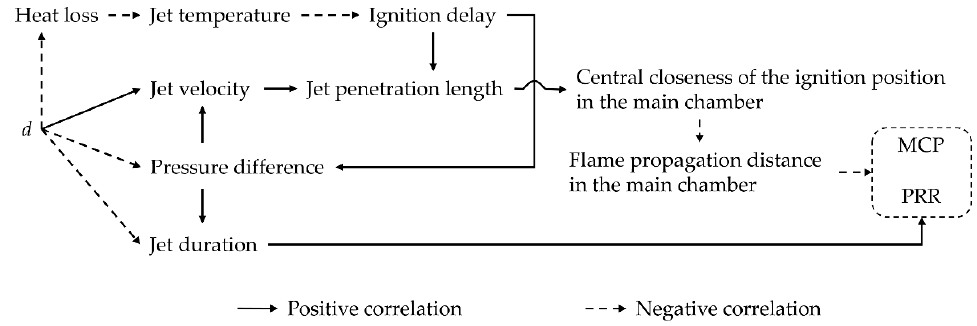
Figure 17. The effects of pre-chamber orifice diameter on the process variables, the jet ignition char- acteristics, and the combustion characteristics. characteristics, and the combustion